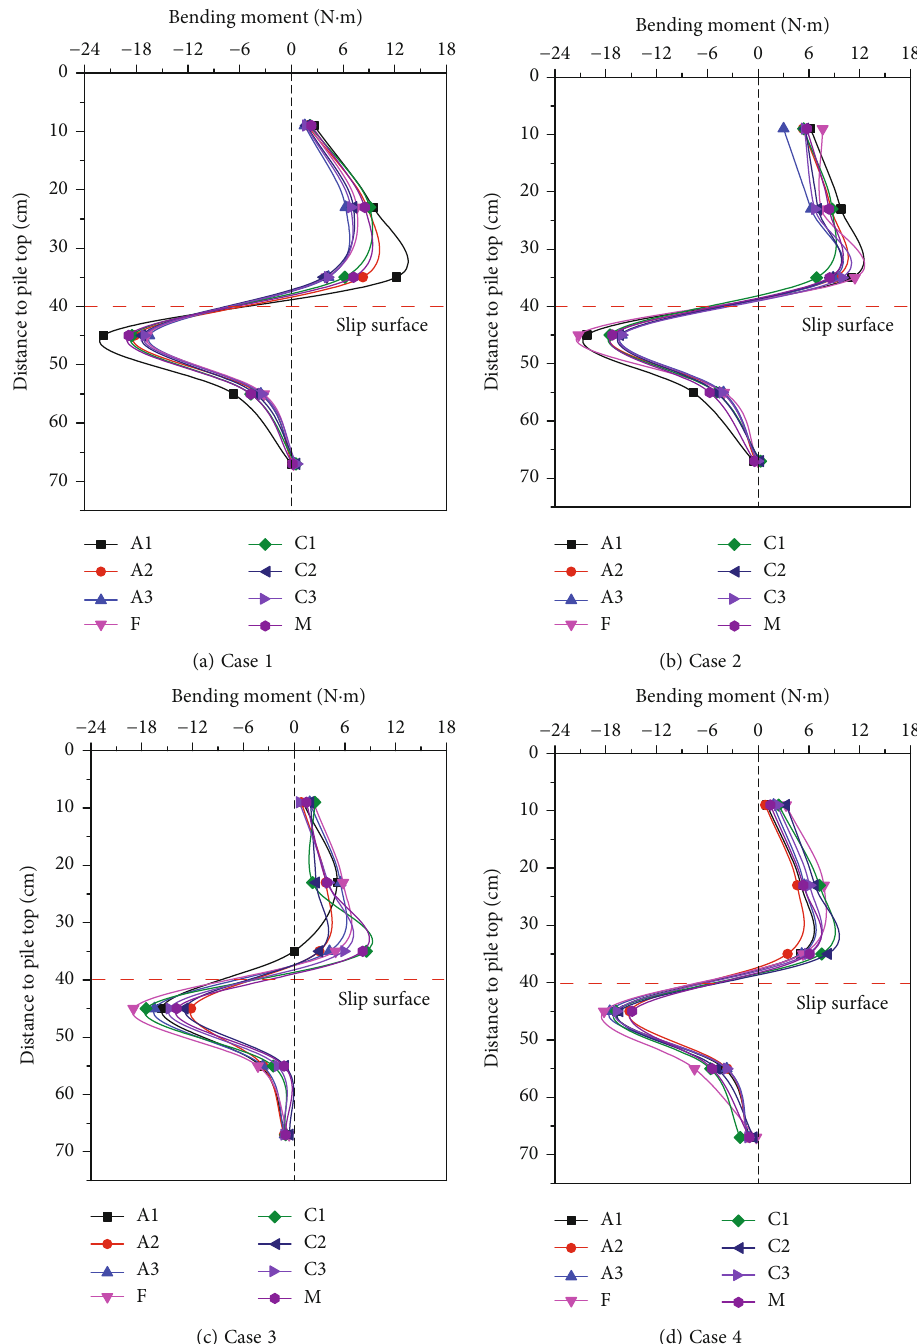
Figure 10: Moment distribution of di ff erent cases ( p = 20 kPa